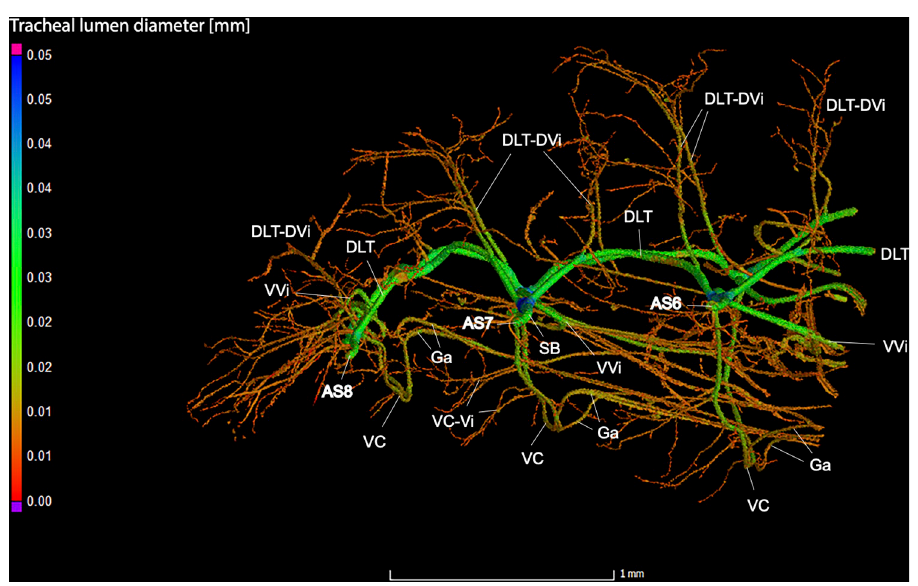
Fig 2. Lateral view of the abdominal tracheal system in Photinus pyralis final instar larva.